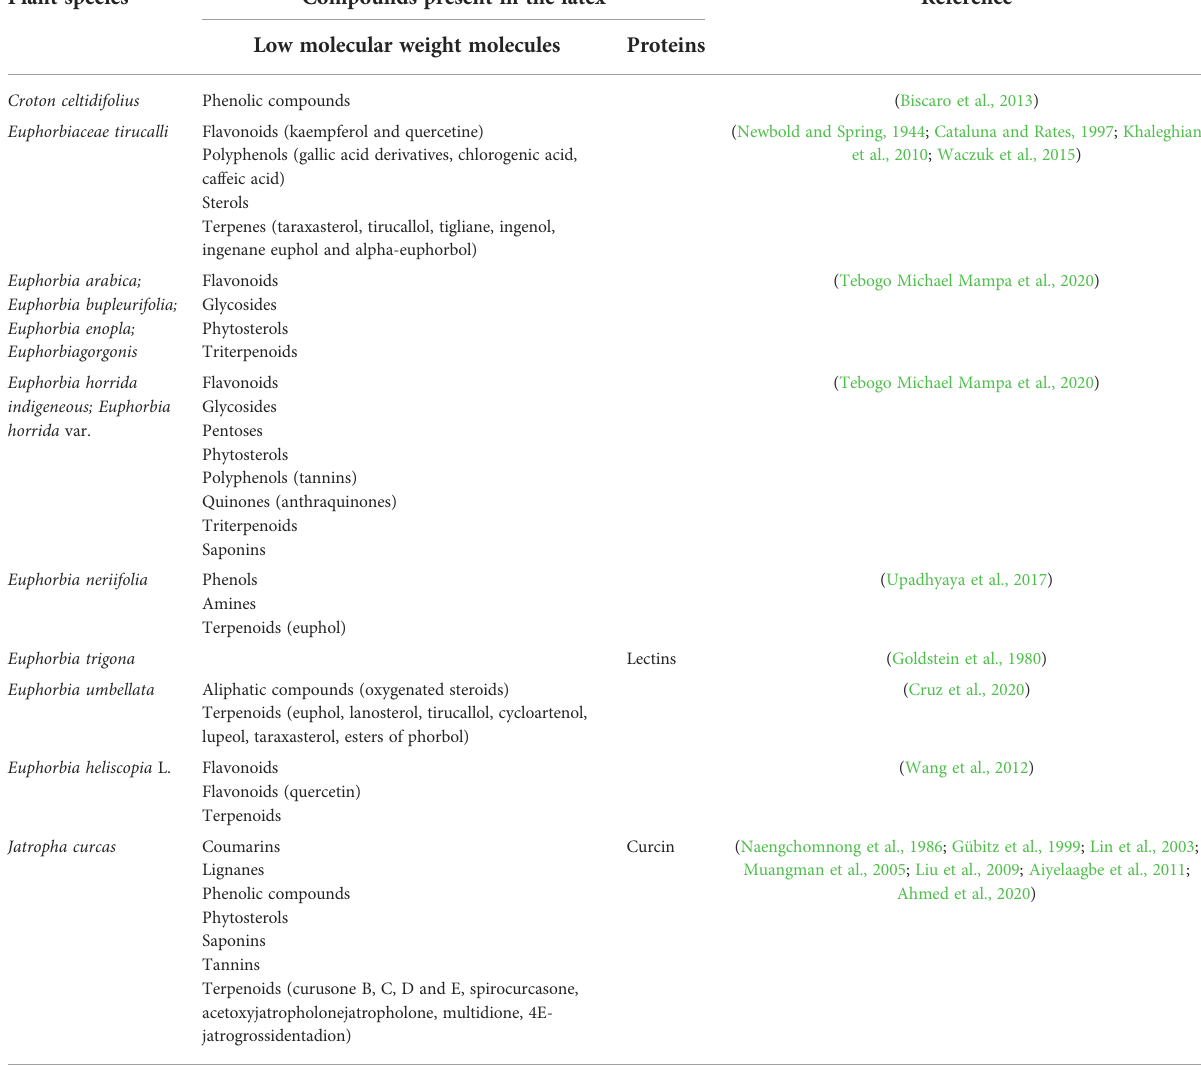
TABLE 4 Biological compounds with potential anticancer activity present in the latex of Euphorbiaceae family representatives. Plant